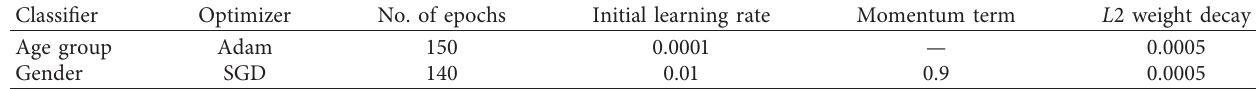
Table 2: Training details with OIU-Adience.